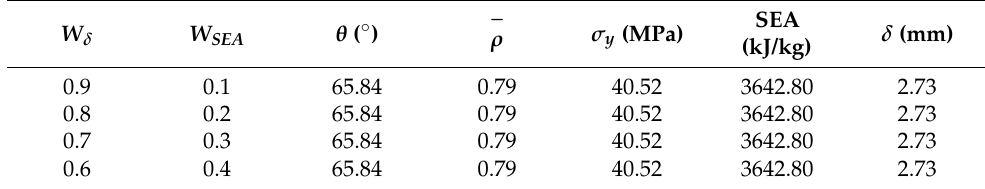
Table 5. Optimum points evaluated by